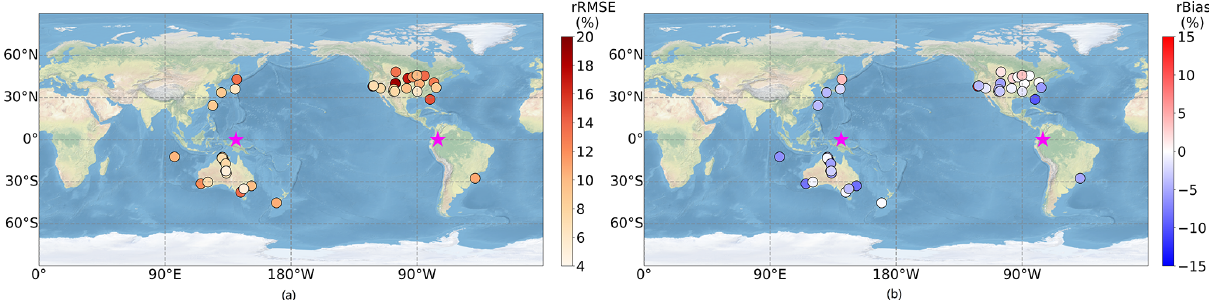
Figure 9. The spatial distribution of rRMSE (relative RMSE) and rBias (relative bias) of DSR estimation. The pink stars represent the position of the AHI and ABI sensors.